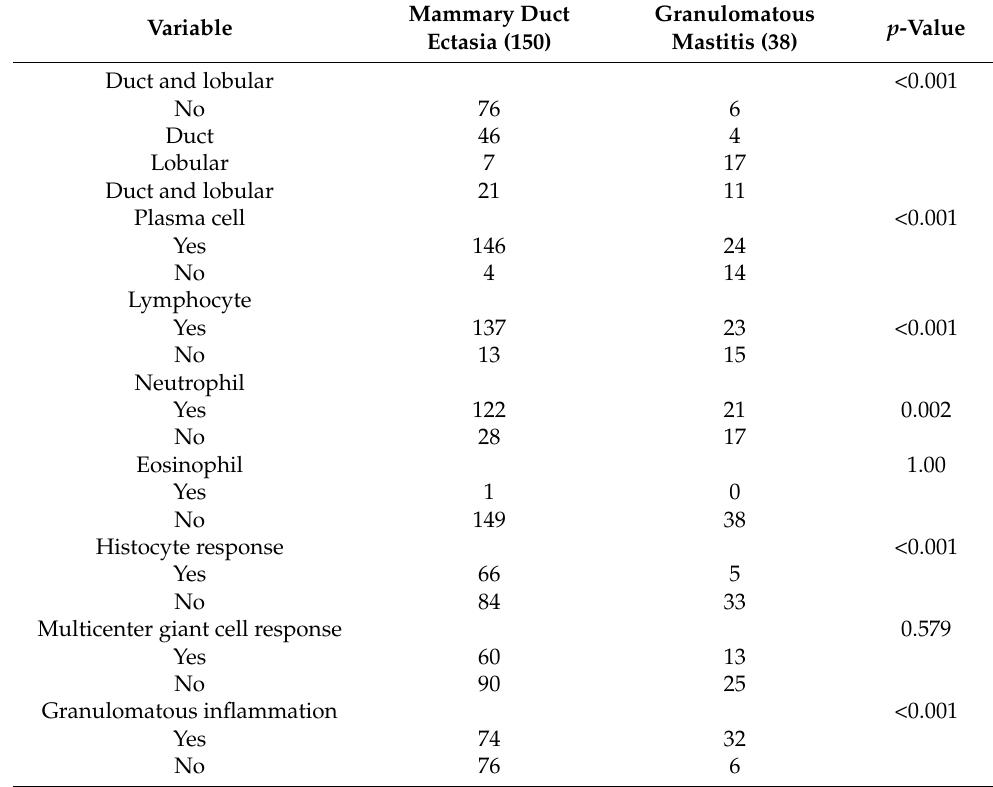
Table 5. Pathological characteristics of non-puerperal